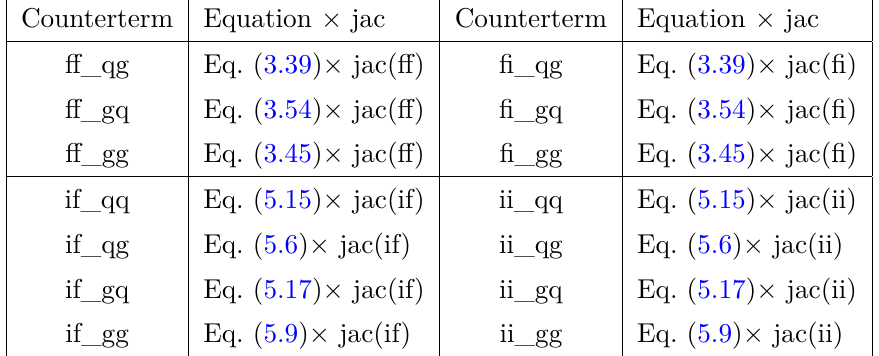
Table 1. Counterterms definition as product of the cut loop integrals in the equations times the corresponding jacobian